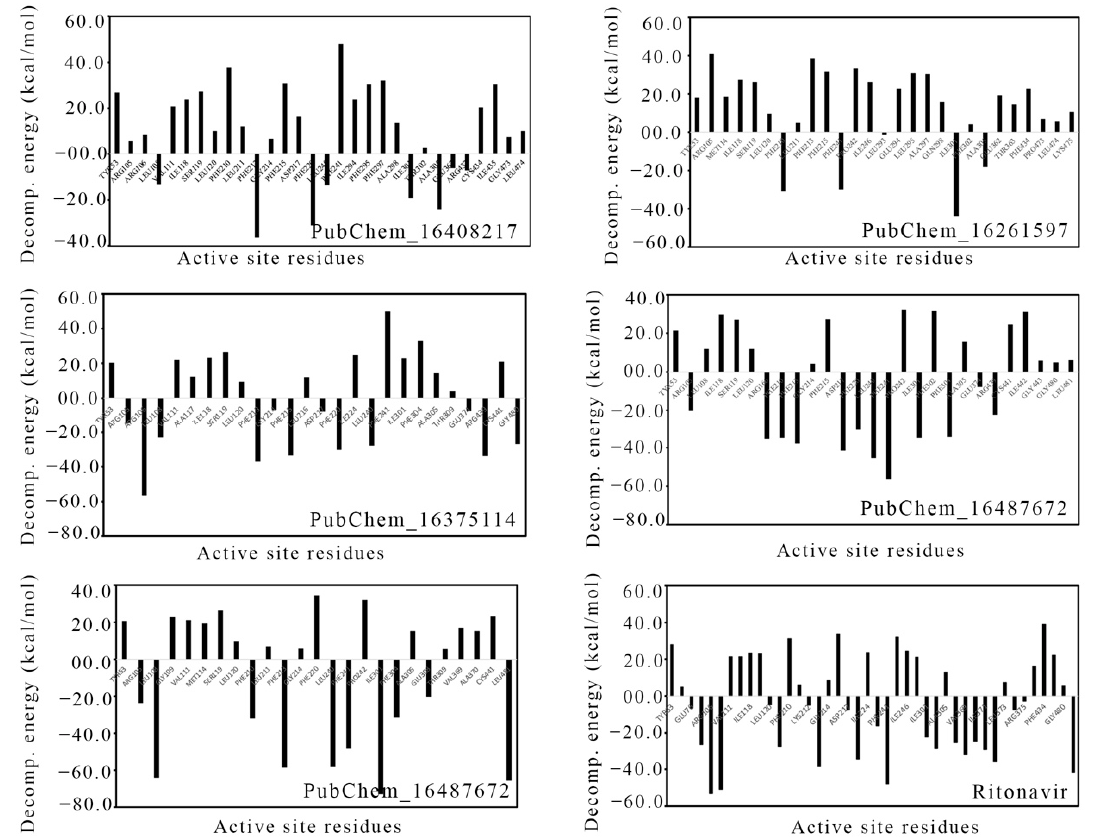
Figure 15. Per-residue decomposition energy of CYP3A5 amino acids around 5 Å of bound ligand.